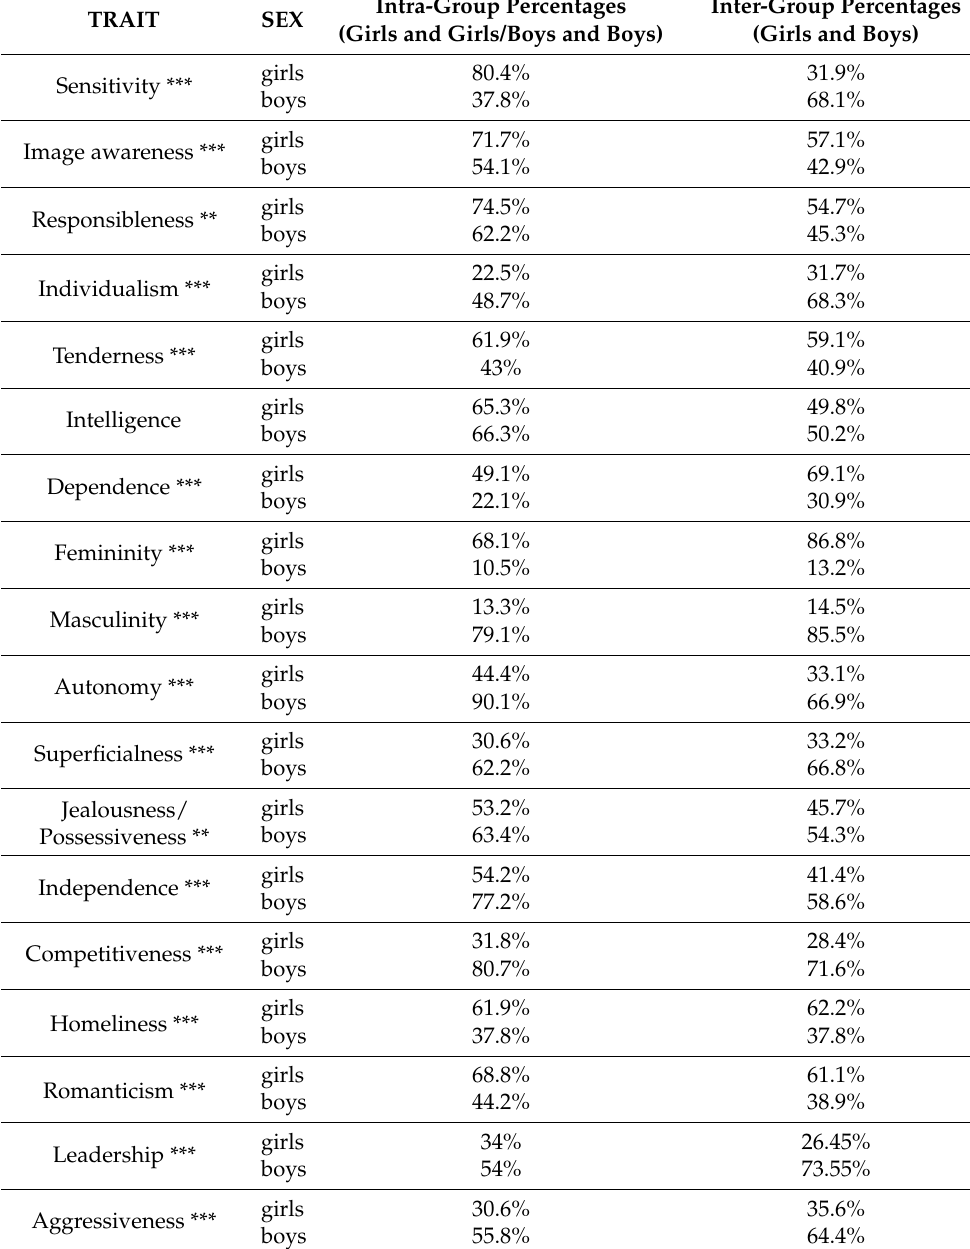
Table 6. Identification with defined traits on social